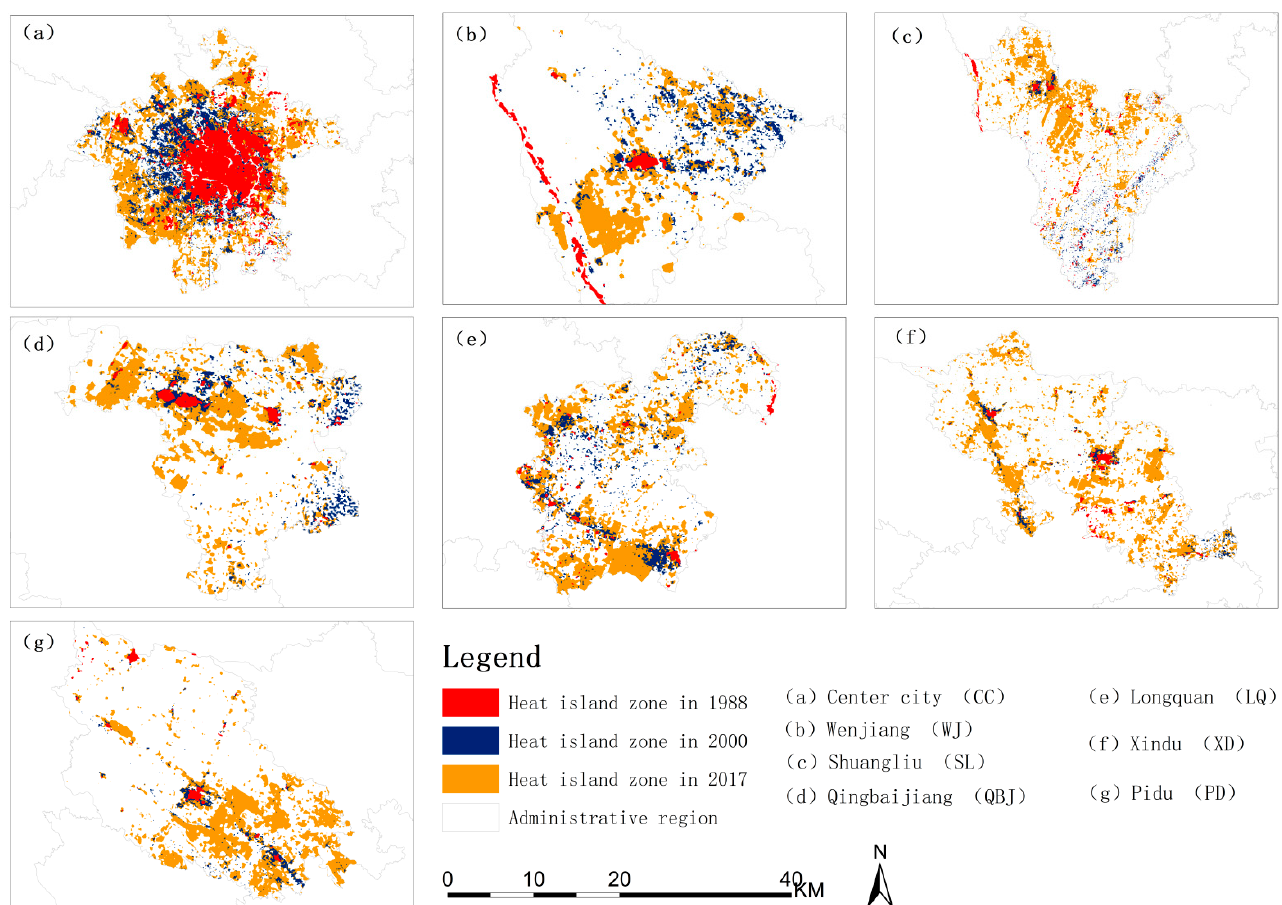
Figure 5. In 1988, 2000, and 2017 urban heat islands area expansion map. ( a ) is the heat island zone of Center city in 1988, 2000, and 2017; ( b ) is the heat island zone of Wenjiang in 1988, 2000, and 2017; ( c ) is the heat island zone of Shuangliu in 1988, 2000, and 2017; ( d ) is the heat island zone of Qingbaijiang in 1988, 2000, and 2017; ( e ) is the heat island zone of Longquan in 1988, 2000, and 2017; ( f ) is the heat island zone of Xindu in 1988, 2000, and 2017; ( g ) is the heat island zone of Pidu in 1988, 2000, and 2017. Table 1. Changes in the area of the heat islands area in the main urban area of